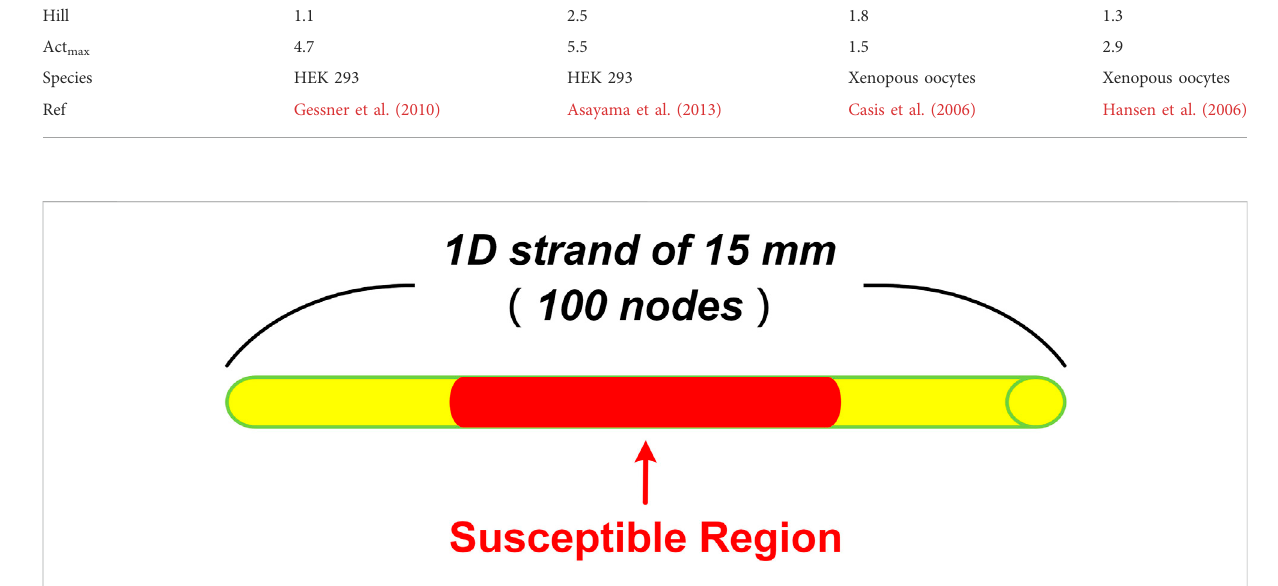
FIGURE 2 Schematicof1DhomogenousventricularstrandmodelwithCO-affectedregions. Thetissueis15 mminlengthandcontains100cells.Thered part in the middle indicates the susceptible region where the number of cells varies from 0 to 100.